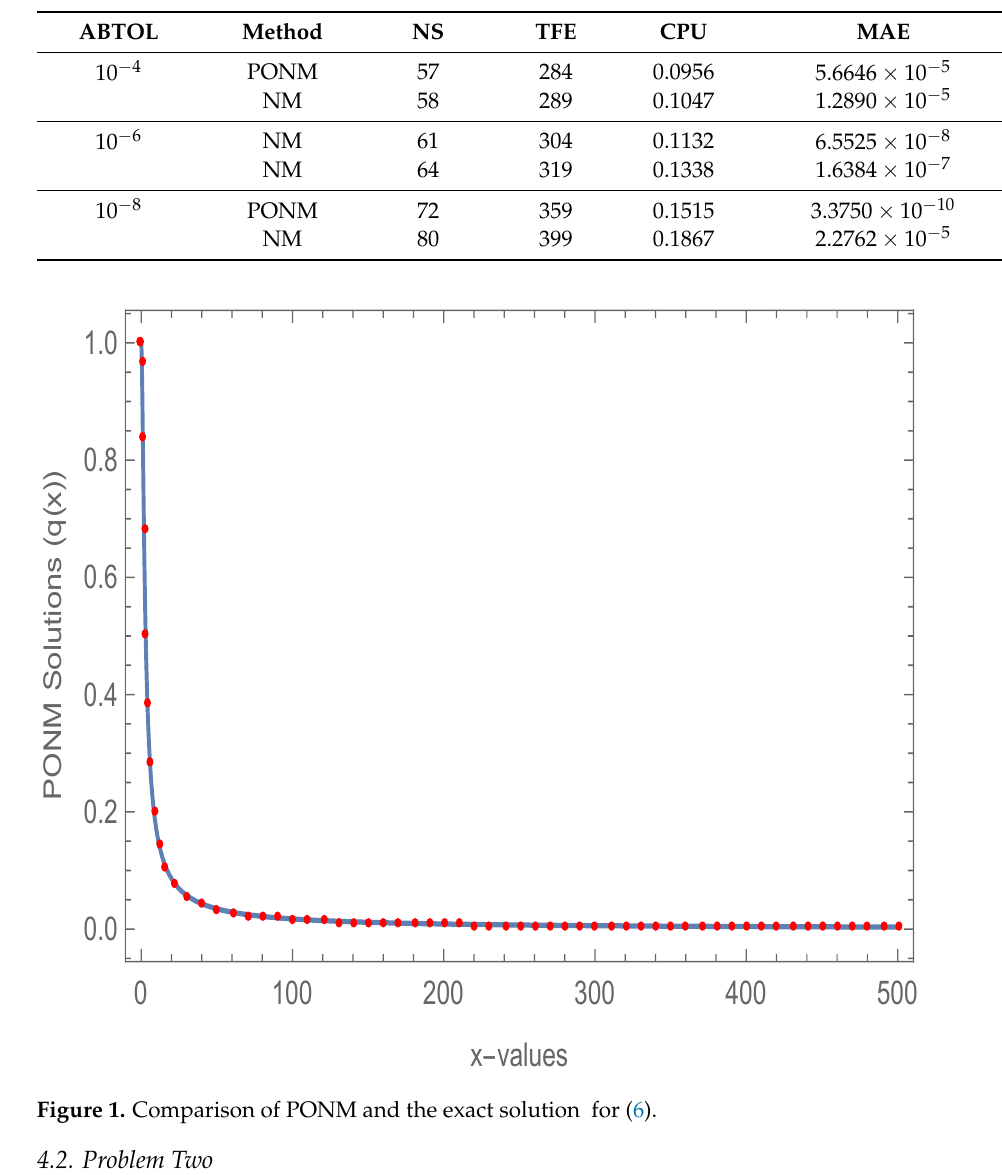
Table 2. Numerical results for (6) with h 0 = 10 − 3 , x ∈ [ 0,500 ] .